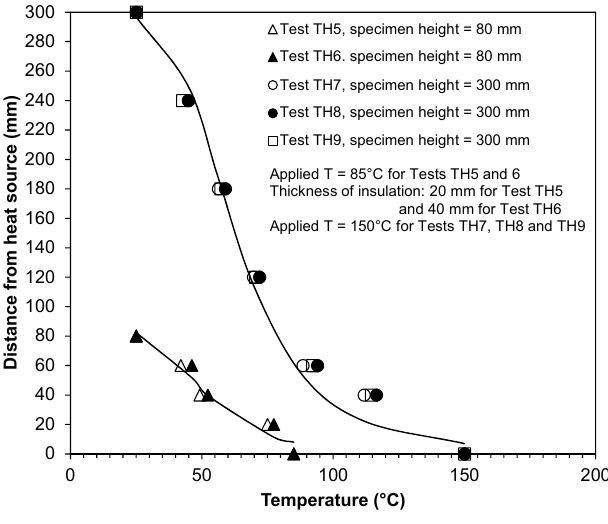
Figure 10. Temperature profiles in the non-isothermal hydraulic tests at 85 °C and 150 °C.